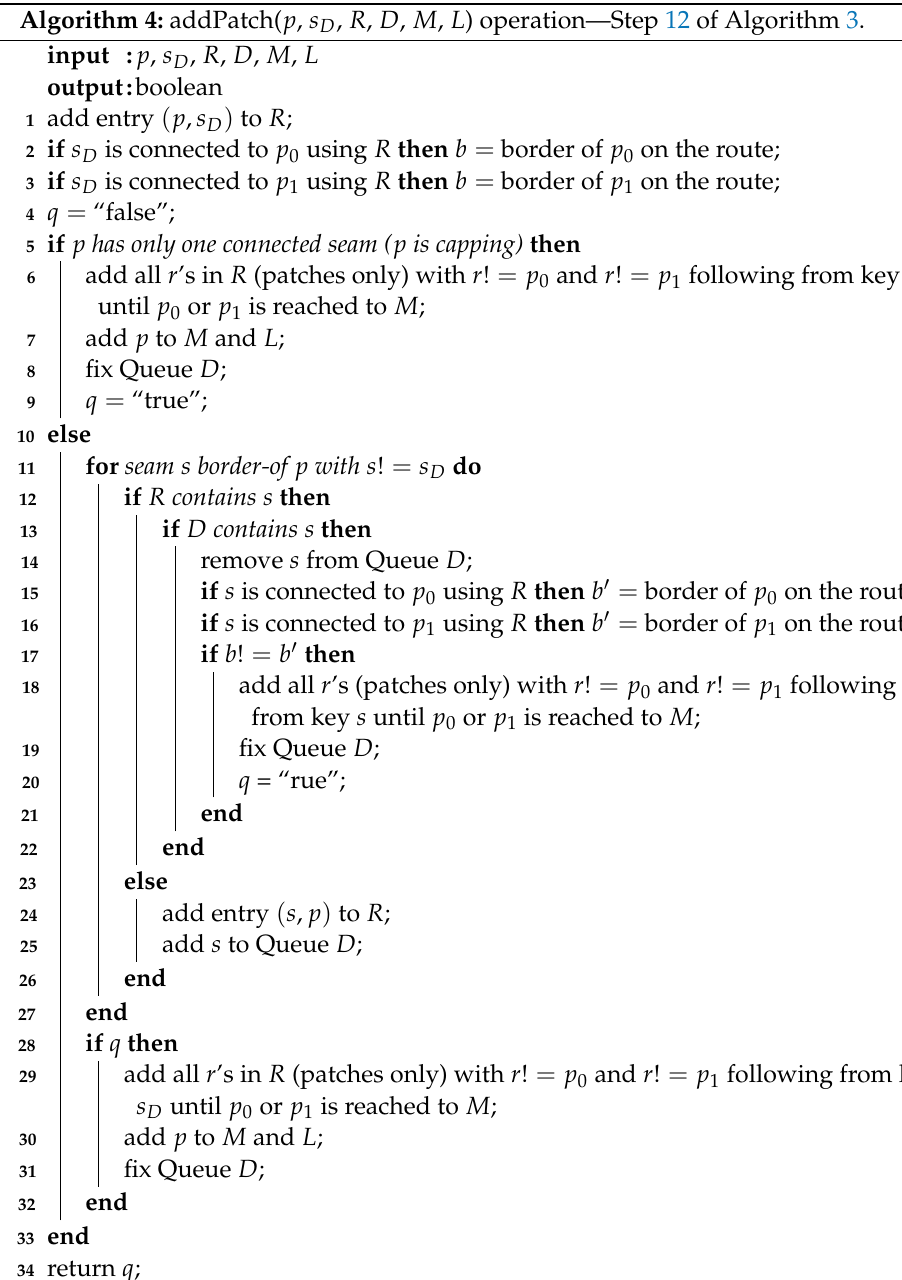
Algorithm 4: addPatch( p , s D , R , D , M , L ) operation—Step 12 of Algorithm